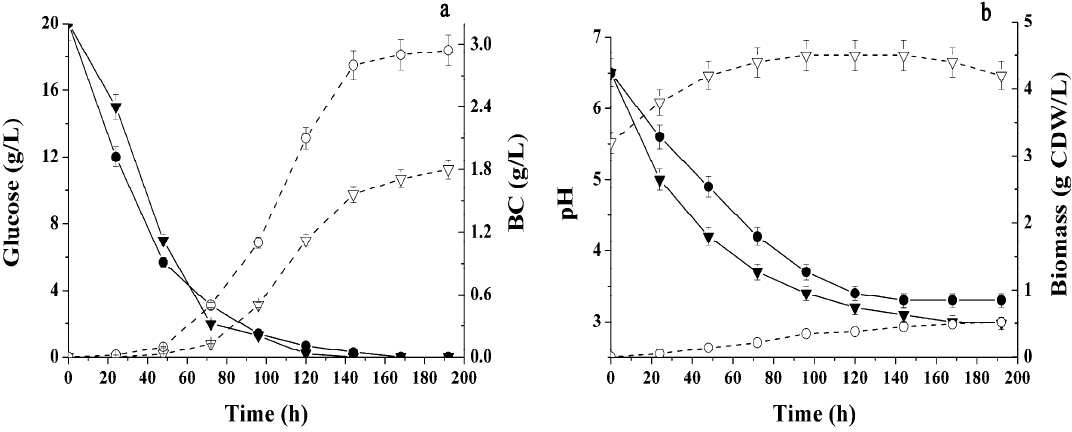
Figure 3. The kinetics of glucose consumption (black symbols) and BC production (white symbols) ( a ); pH changes (black symbols) and accumulation of free cell biomass (white symbols) ( b ) in the Hestrin–Schramm (HS) ‐ medium with Komagataeibacter xylinum B ‐ 12429 cells taken in free (triangles) and immobilized (circles) forms. CDW (cell dry weight).